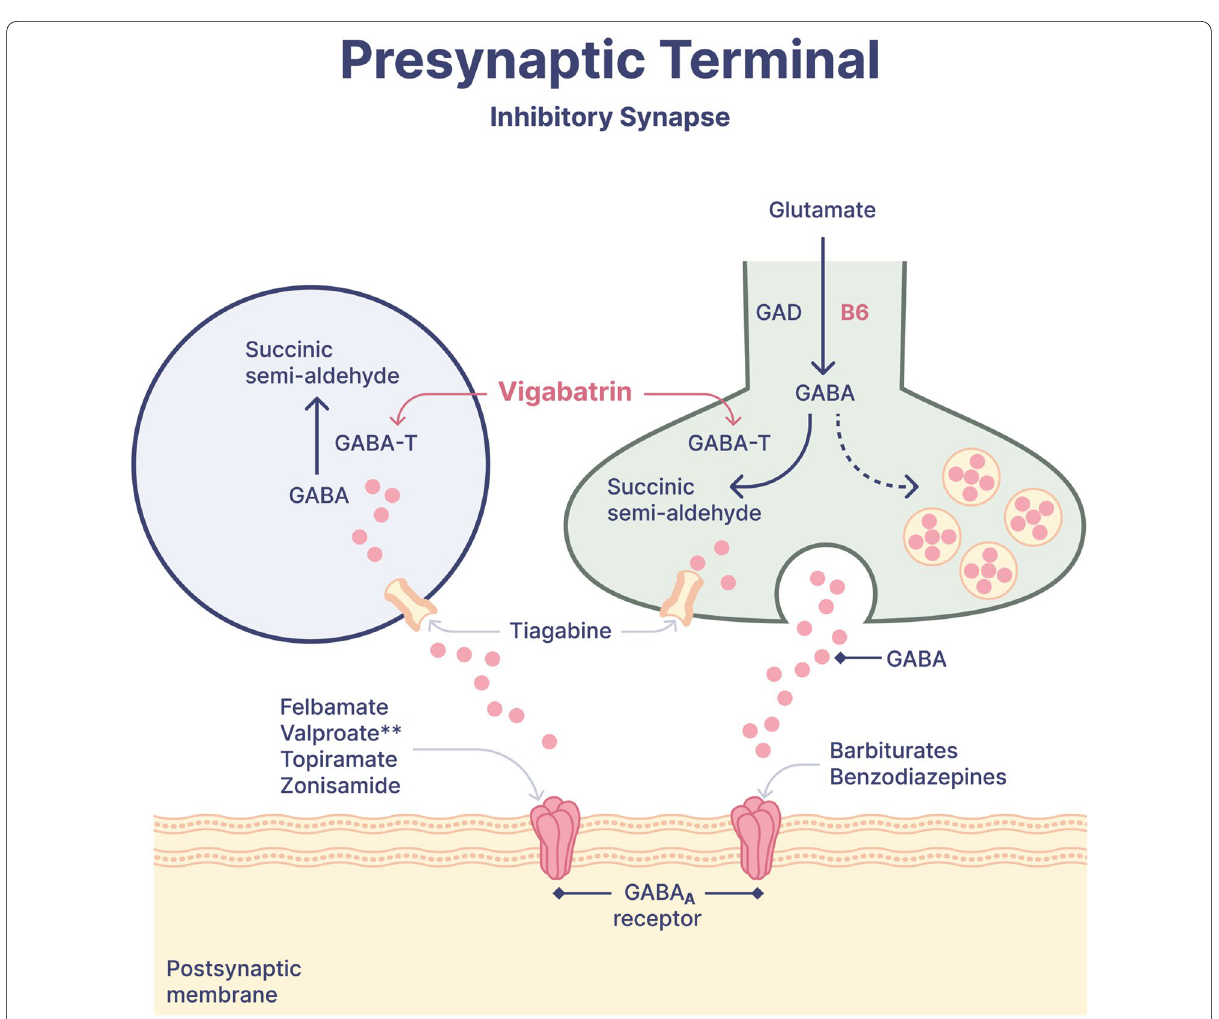
Fig. 1 Vigabatrin mechanism in the inhibitory